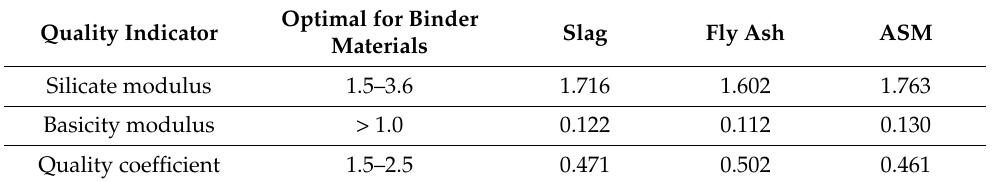
Table 3. Quality indicators of the studied raw